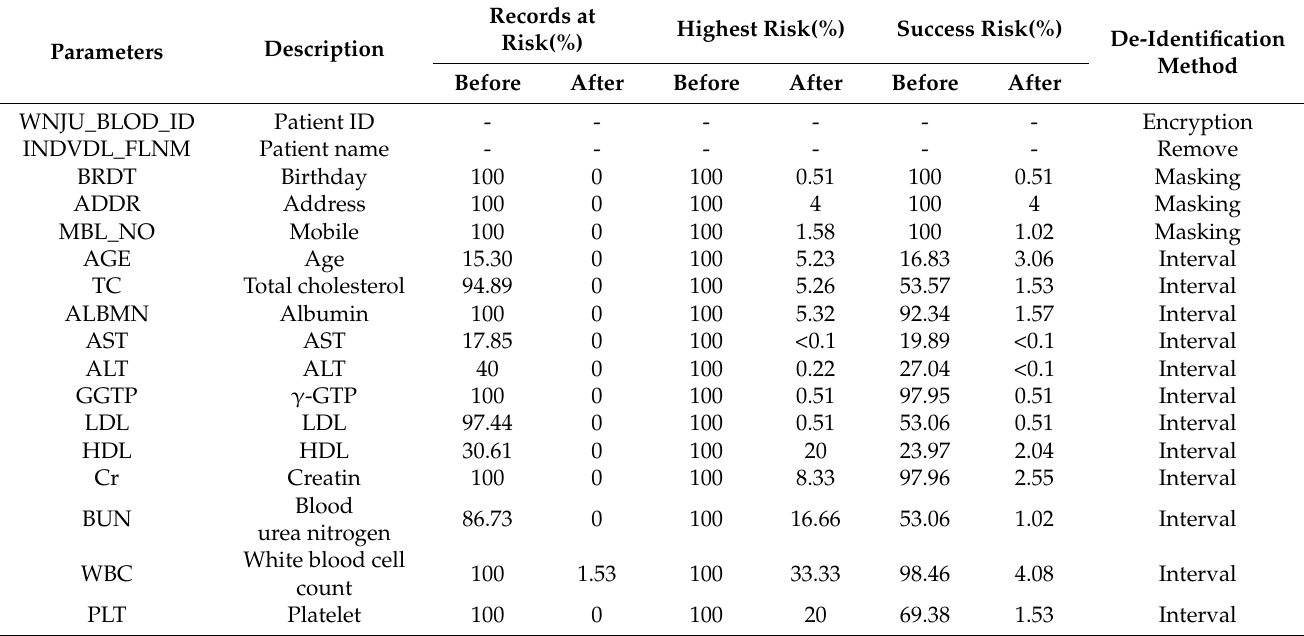
Table 5. The result of de-identification.